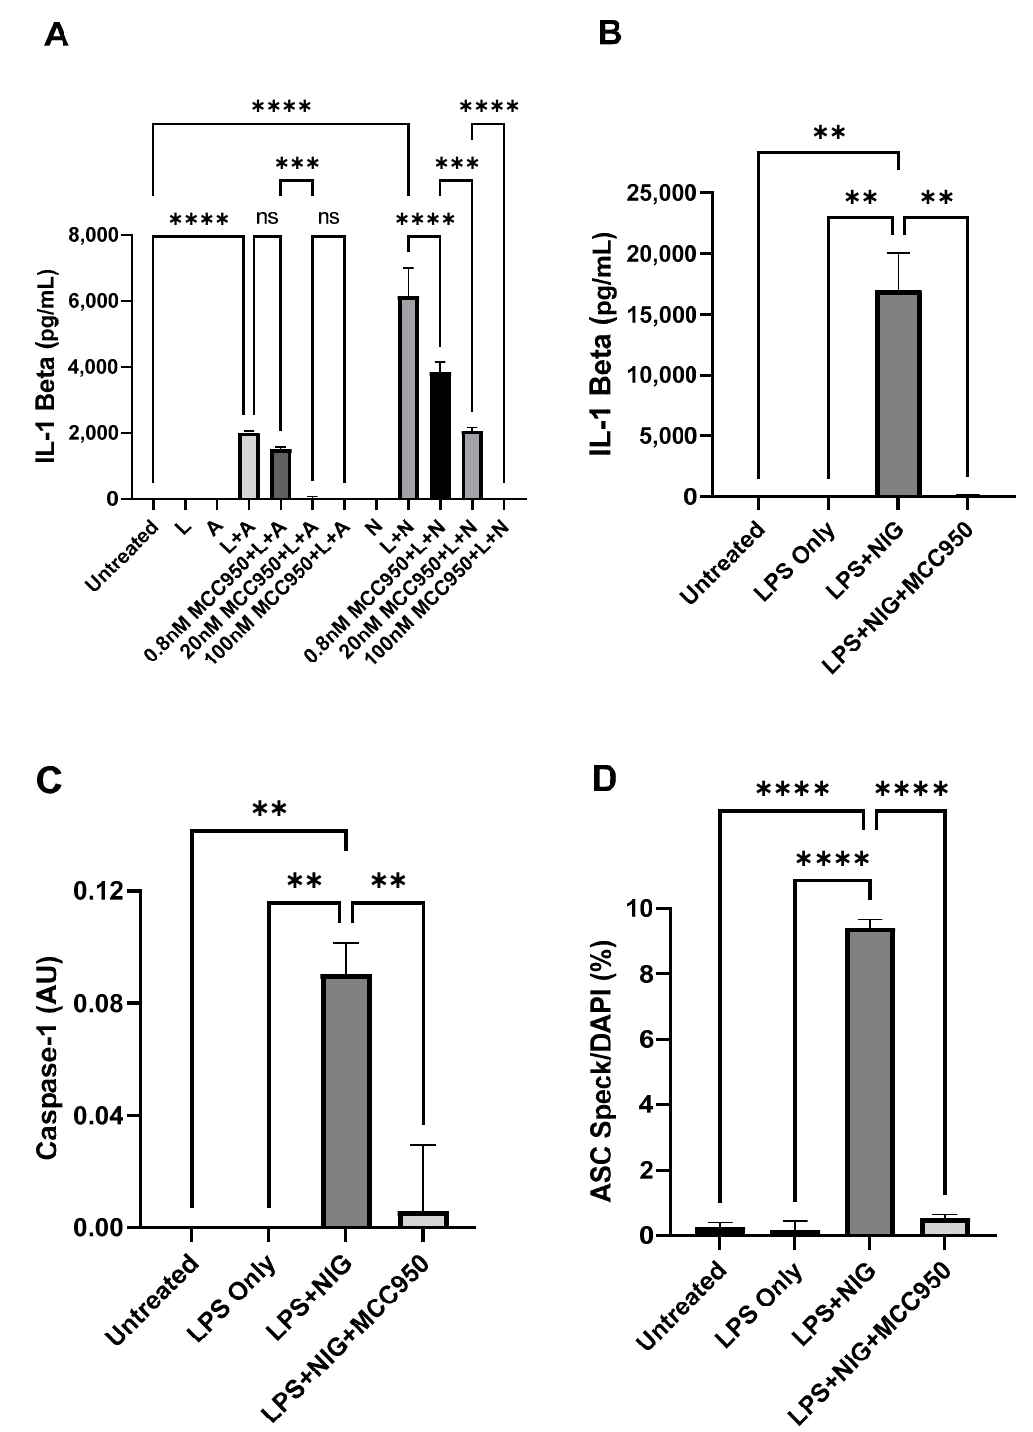
Figure 1. Validation of NLRP3 inflammasome endpoints in healthy PBMC. ( A ) Response of IL-1 beta with increasing doses of NLRP3 inhibitor MCC950 prior to stimulation with 100 ng/mL LPS and 10 µM nigericin or 5 mM ATP in 1 million cells per mL, measured by ELISA. ( B , C ) Levels of IL-1 beta ( B ) and Caspase-1 ( C ) in cell culture supernatants under NLRP3 activator and inhibitor conditions in 2 million cells per mL, as measured by ELISA; 100 nM of MCC950 was used in inhibitor treatments. AU refers to arbitrary units. ( D ) ASC Speck formation under various conditions as measured by fluorescence microscopy. Data in ( A ) are expressed as the mean and standard deviations of two technical replicates from a single experiment, while data in ( B – D ) are expressed as the mean and standard deviations of two independent experiments. One way ANOVA followed by Š í d á k’s multiple comparison test was used to assess differences between groups (** adj. p < 0.01, *** adj. p < 0.001, **** adj. p <